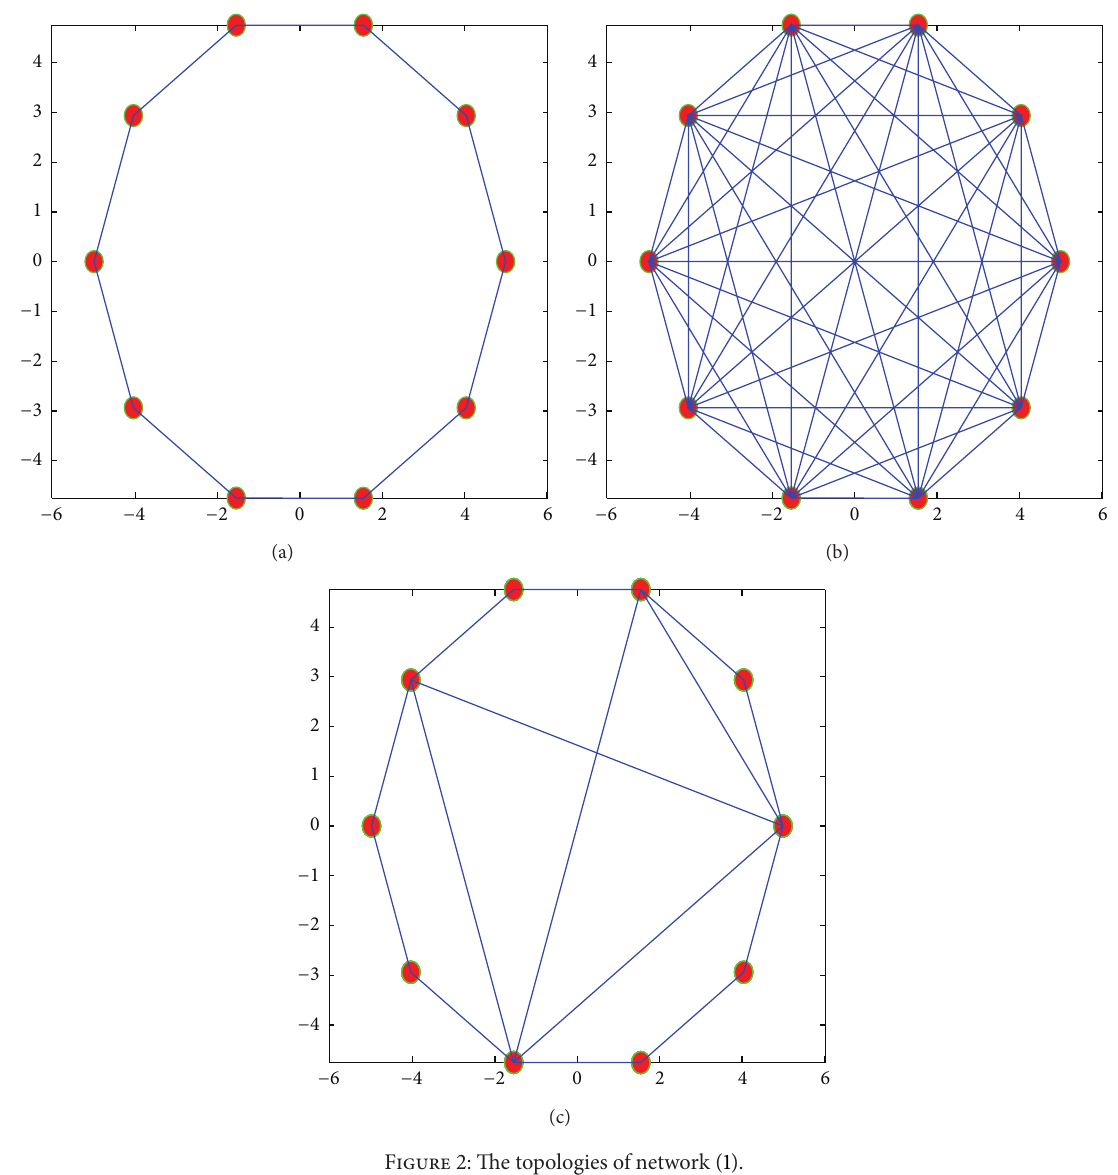
Figure 2: The topologies of network